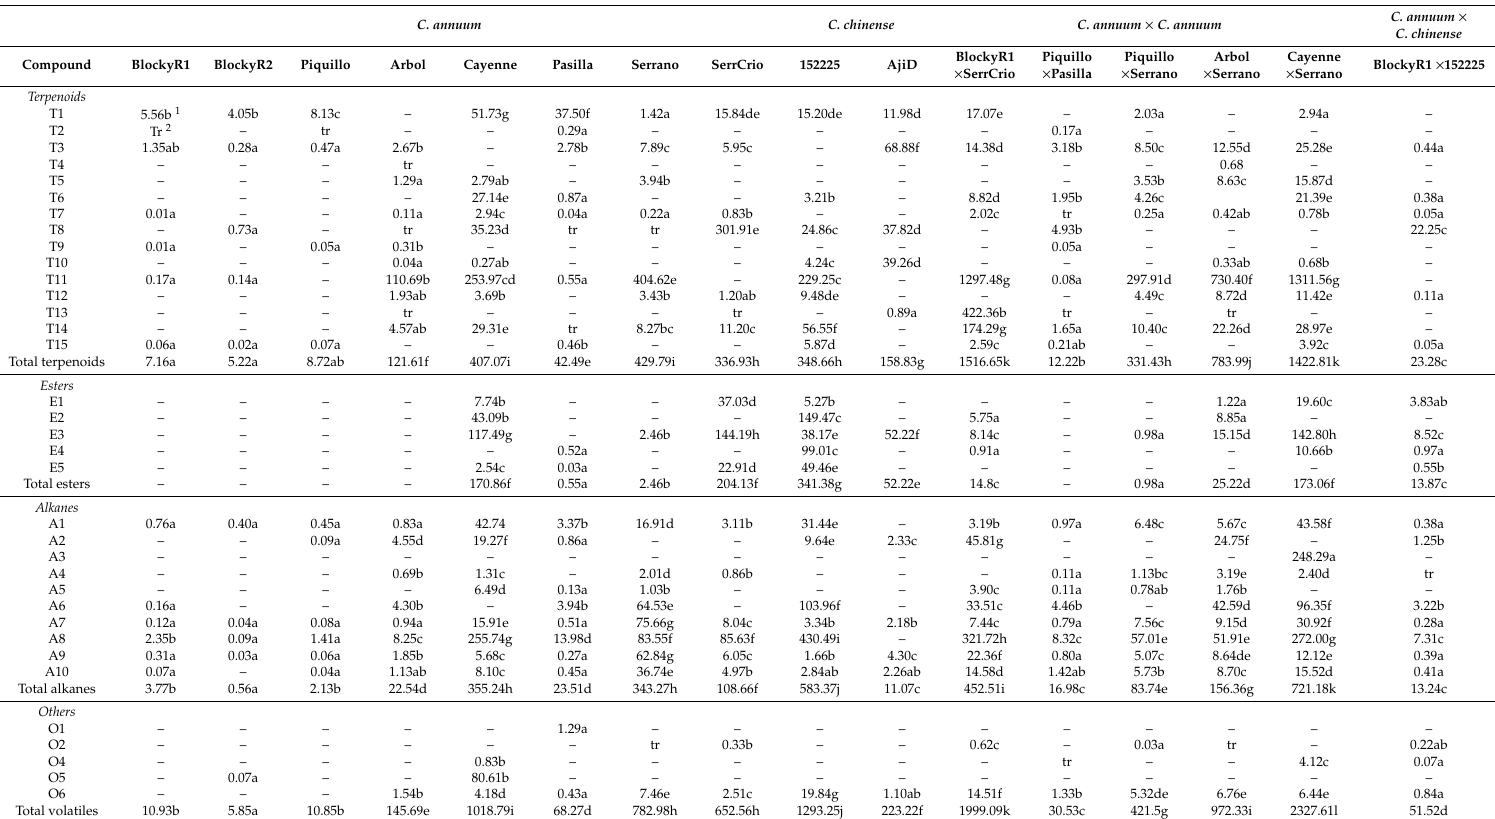
Table 4. Individual compounds and their average GC peak areas ( × 10 6 ) identified in the placental tissues of the Capsicum accessions and hybrids